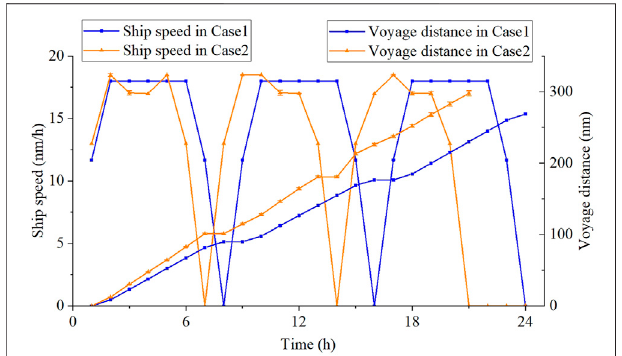
FIGURE 4 | Voyage